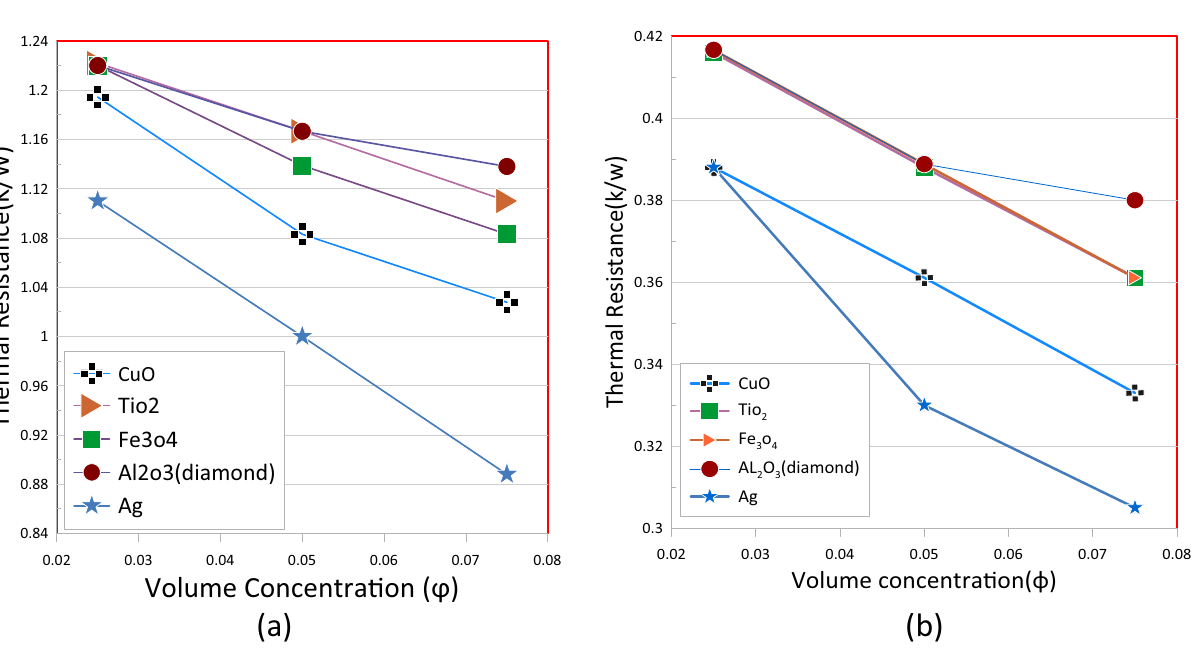
Figure 15. Overall thermal resistance versus volume concentration of various types of nanofluid ( a ) Re = 200, ( b ) Re =